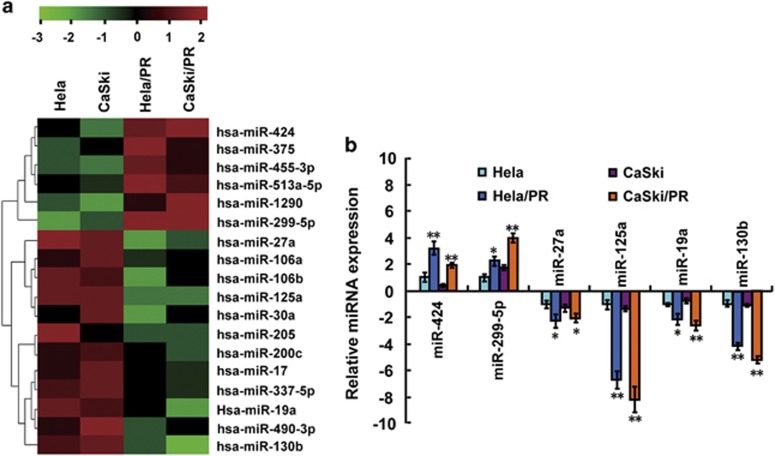
Different expression of miRNAs in paclitaxel-sensitive and -resistant CC cells. (a) A heat map showing the miRNA expression profiles and supervised hierarchical clustering analysis for paclitaxel-sensitive (HeLa and CaSki) and -resistant (HeLa/PR and CaSki/PR) CC cell lines. Significantly differentially expressed miRNAs matched the threshold (differential ⩾2-fold, chip signal value >500) and statistical analysis standard were selected (P<0.05). Each column represents a cell line and each row shows the relative expression level for individual miRNAs. The red and green colors indicate high of low expression, respectively. (b) Expression of six miRNAs (miR-424, miR-229-5p, miR-27a, miR-125a, miR-19a and miR-130b) in the CC cell lines were validated by RT–PCR. U6 small nuclear RNA was used as an internal control. All values are the mean±s.d. of triplicate measurements, and experiments were repeated three times. *P<0.05, **P<0.01 compared with matched CC cells.